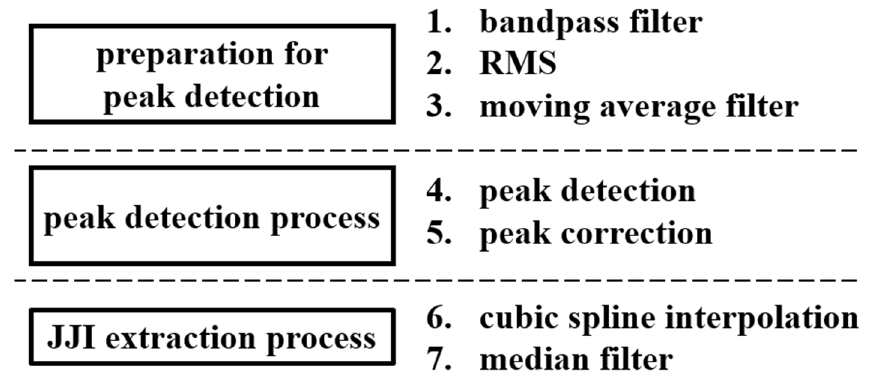
Figure 4. JJI extraction method.